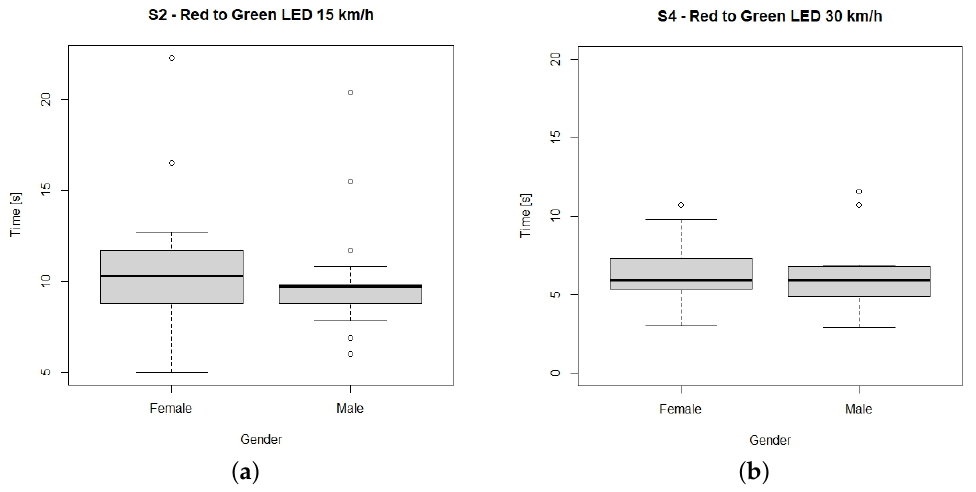
Figure 4. Time required to make the decision to cross by gender. ( a ) Scenario 2, ( b ) Scenario